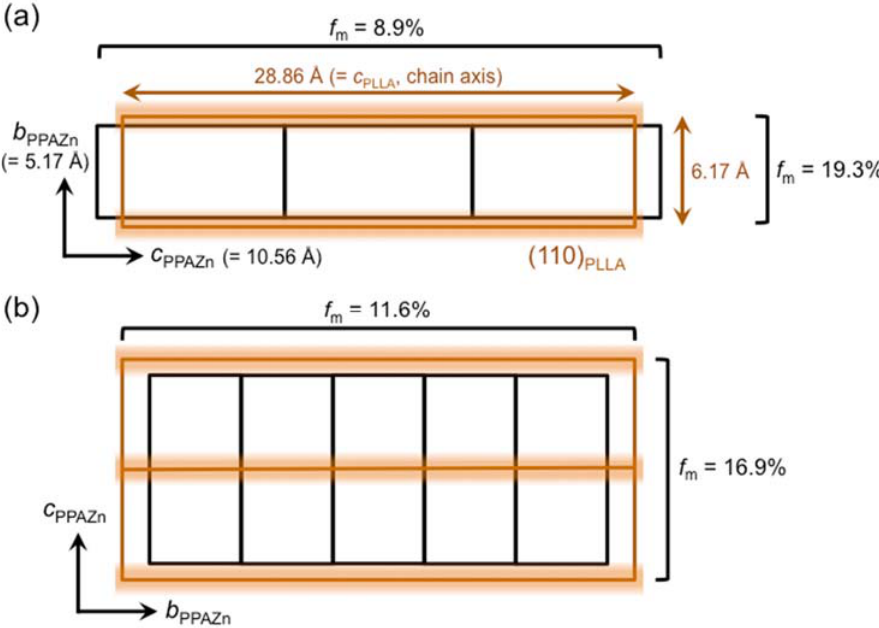
Figure 9. Lattice matching between the (110) PLLA -plane and the bc PPAZn -plane under the assumptions of ( a ) c PPAZn being parallel to c PLLA ( c PPAZn  c PLLA ) and ( b ) b PPAZn  c PLLA